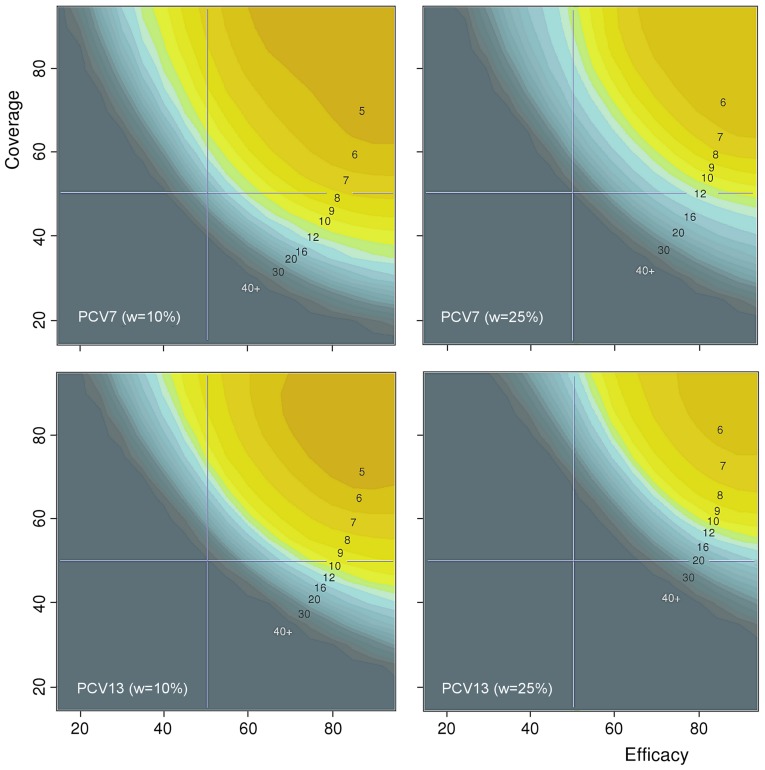
Thresholds for elimination of vaccine-type carriage among children less than five years of age.The figure shows the time in years until near elimination (5% of the level of vaccine-type carriage prevalence in the pre-vaccination era) for PCV7 and PCV13 and for different combinations of the values of vaccine efficacy against carriage (horizontal axis in each plot) and coverage of vaccination (vertical axis). Left panels: The waning rate of vaccine-induced immunity against carriage is 10% per year. Right panels: the waning rate is 25% per year. Upper panels: PCV7. Lower panels: PCV13. The numbering within each panel corresponds to lower limits (in years) of the respective colour codes, with 40+ corresponding to 40 or more years until near elimination. The results were obtained using the most optimal parameter combination. For results corresponding to the 50 most optimal parameter combinations, see Figure S3.2 in File 3.